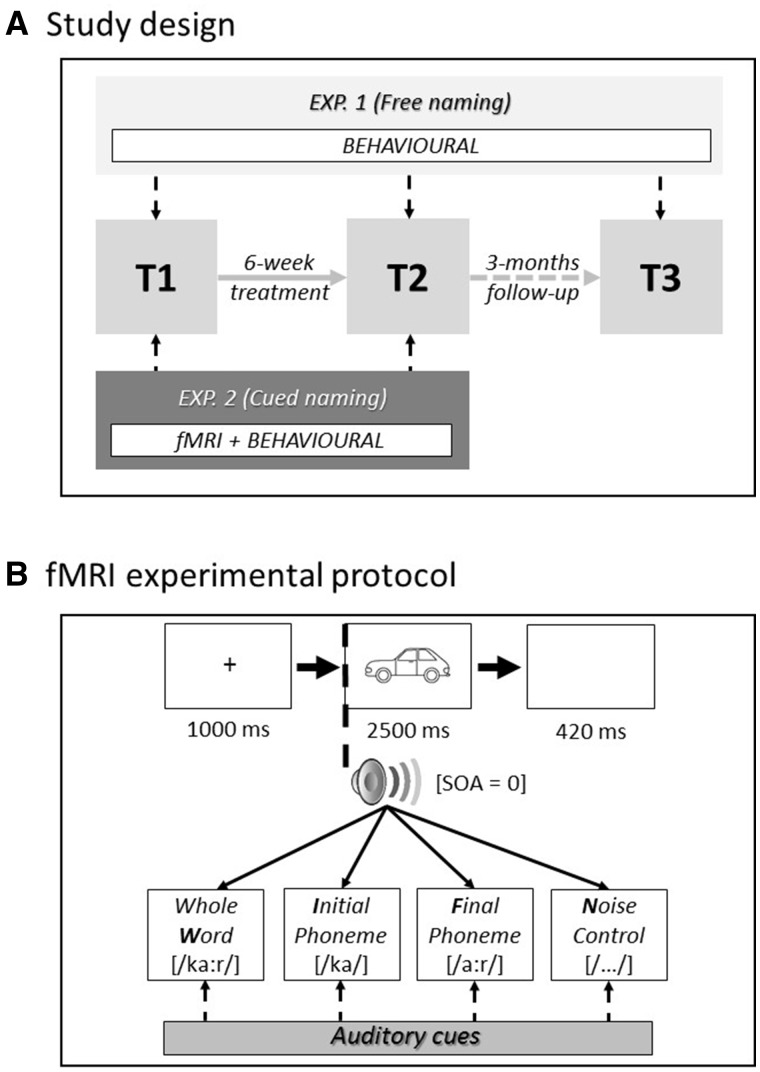

Study design (A) and functional MRI experimental protocol (B). fMRI = functional MRI; SOA = stimulus-onset asynchrony.